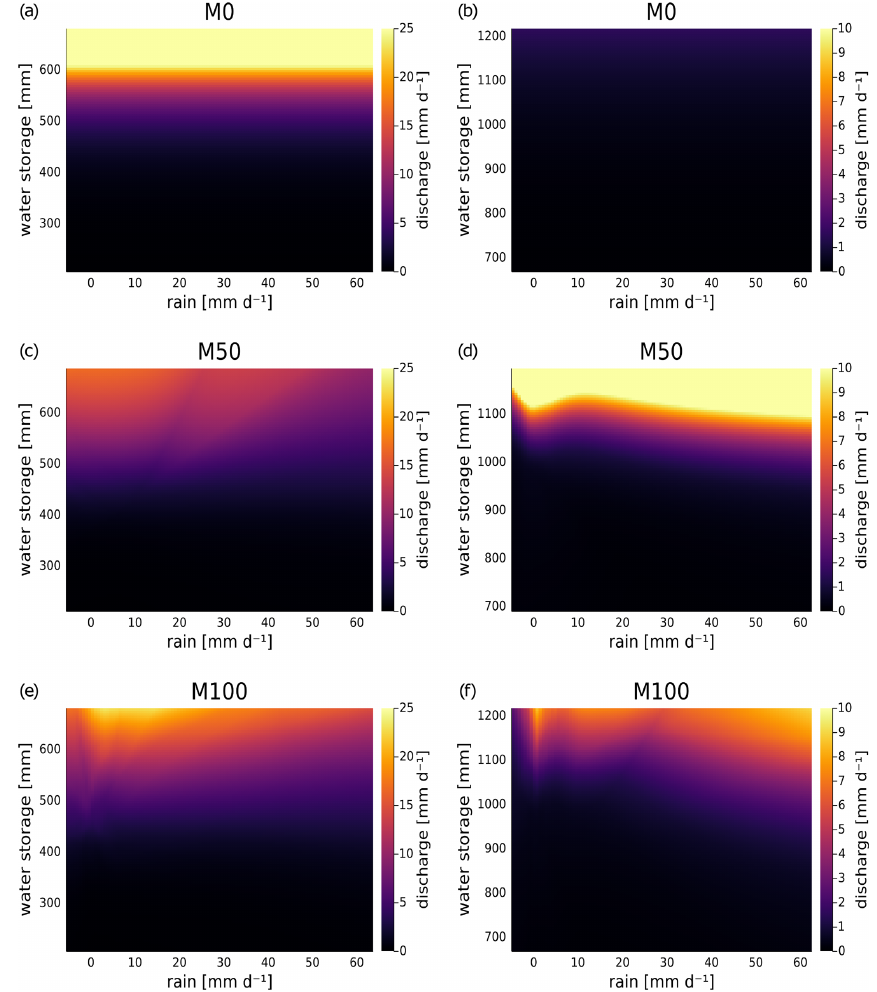
Figure 5. Dependence of discharge on precipitation (rain) and water storage for neural ODE models M0, M50 and M100 in basin 1013500 (left; a , c and e , respectively) and in basin 6431500 (right; b , d and f , respectively). For NN 100 the additional neural network input snow storage was fixed at 0 in both basins, and temperature was fixed at the average temperatures over the training period (3.3 ◦ C for basin 1013500 and 5 ◦ C for basin